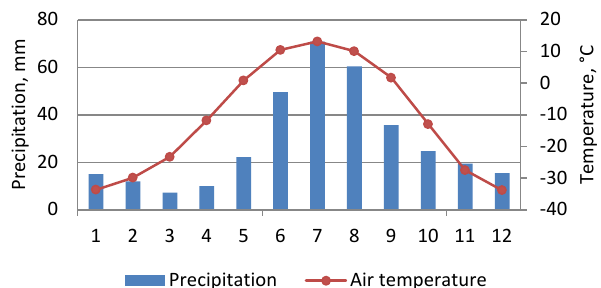
Figure 10. Mean monthly precipitation (mm) and air temperature ( ◦ C) at Nizhnyaya weather station,